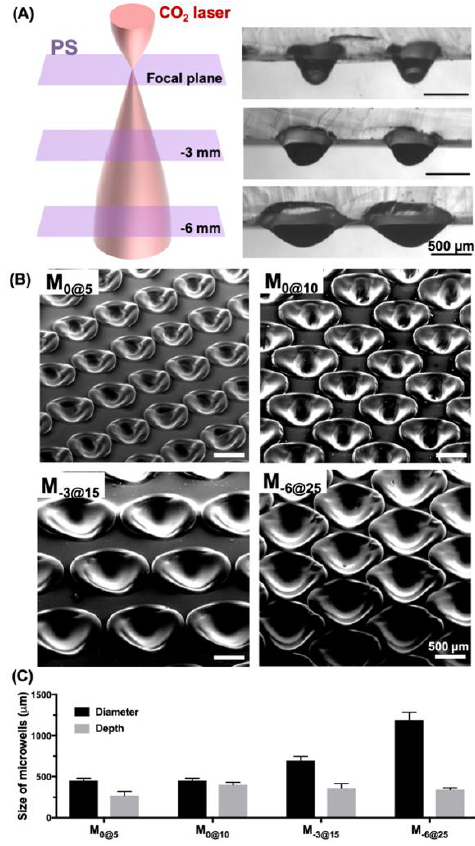
Figure 2. Microwells fabricated via in / out-of-focus laser ablation to generate a wide range of sizes. ( A ) Schematic illustration of incremental z-axis changes showing the gradually enlarged laser beam at di ff erent in / out-of-focus planes from 0 mm to − 6 mm. ( B ) SEM images of the isometric view of microwells fabricated at di ff erent levels of laser power and various focusing planes. ( C ) Characterization of microwell diameters and depths at di ff erent levels of laser power and various focusing planes.